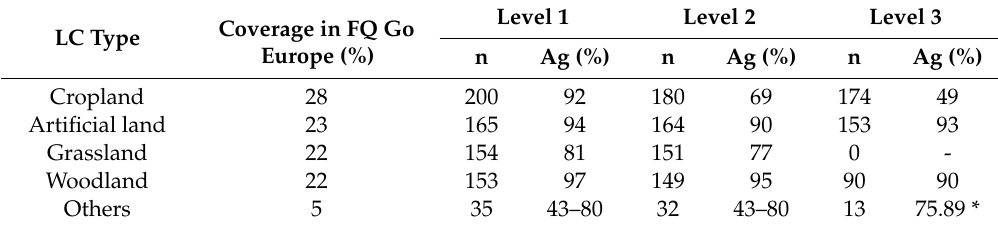
Table 4. LC percent agreement between FotoQuest Go 2018 and LUCAS 2018 for the main LC types by level. The data are sorted by the coverage of these areas in the FotoQuest Go Europe 2018 campaign in descending